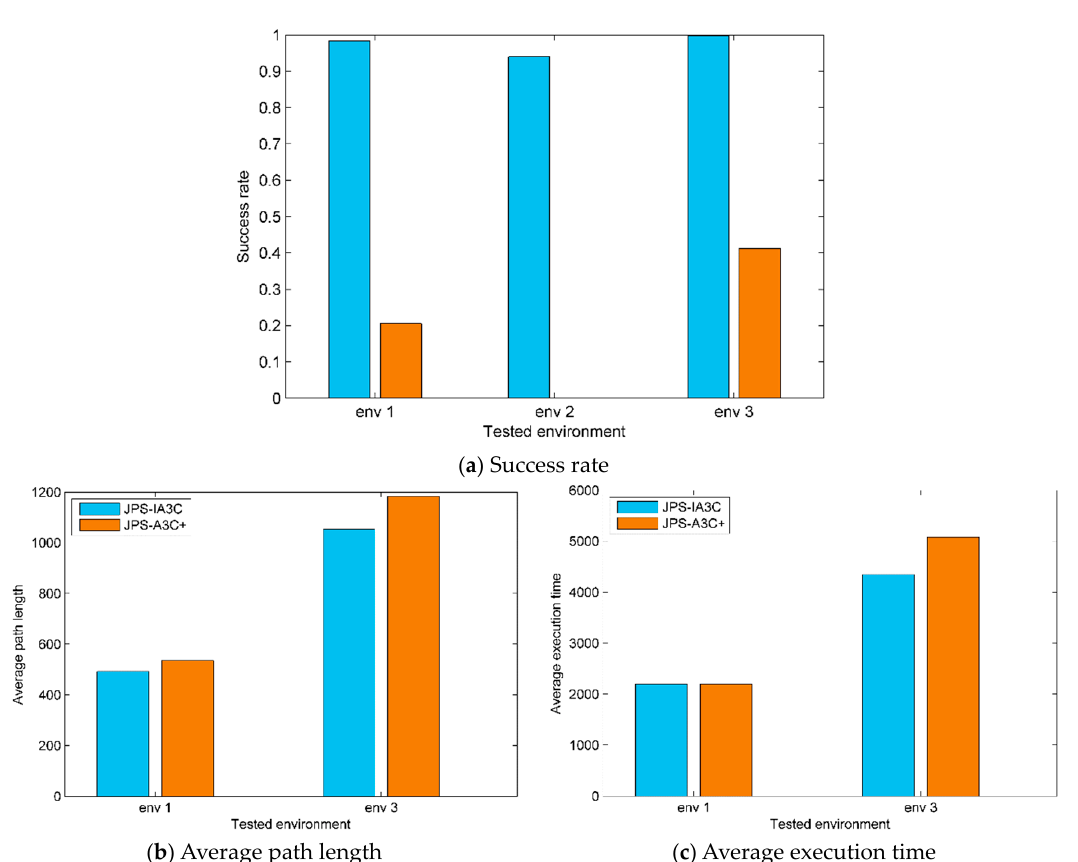
Figure 10. We generate 500 navigation tasks in each tested environment (in sum 1500) whose starting and goal points are randomly chosen. The distance between the initial starting and goal position is greater than half of the width of the environment. ( a ) Success rate denotes the probability of successfully finishing tasks. ( b ) Path length denotes the traveling length between the starting and goal position. ( c ) Execution time denotes the total execution time for the motion controller.